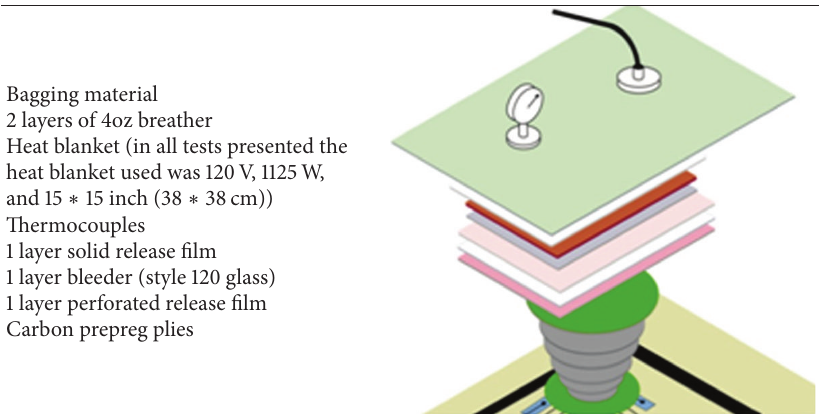
Table 2: Lay-up before curing in repair clave